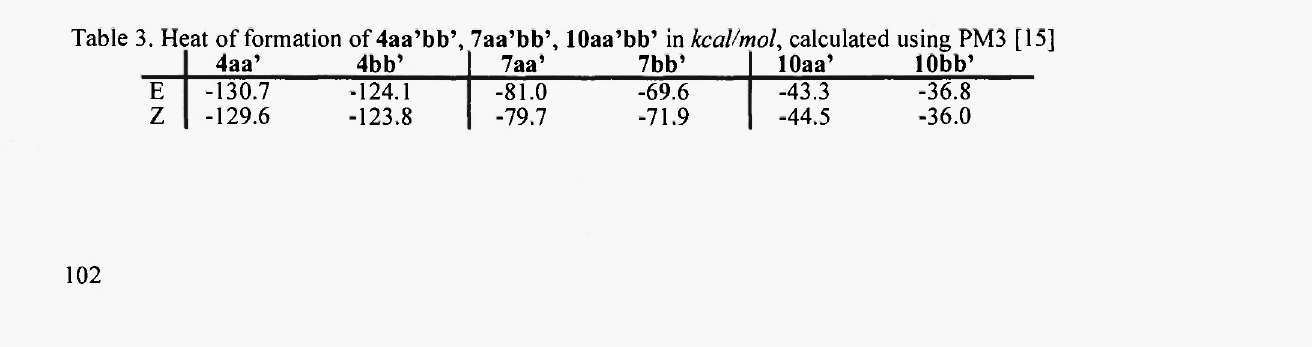
Table 3. Heat of formation of 4aa'bb\ 7aa'bb\ lOaa'bb' in kcal/mol, calculated using PM3